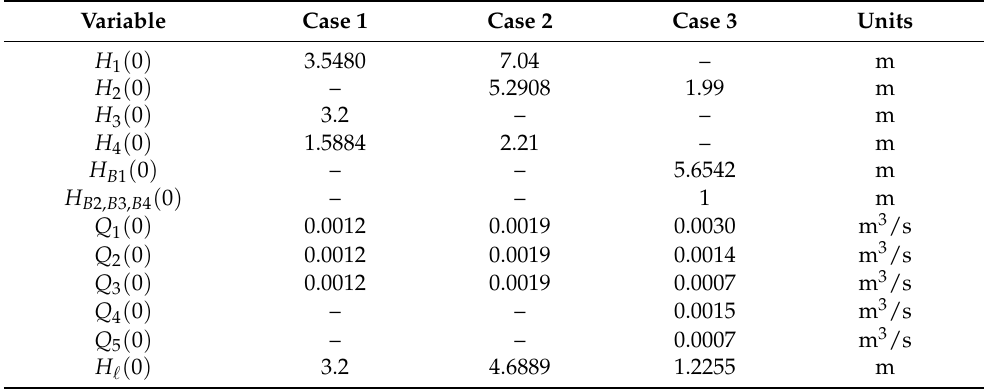
Table 2. Initial conditions for the three simulation